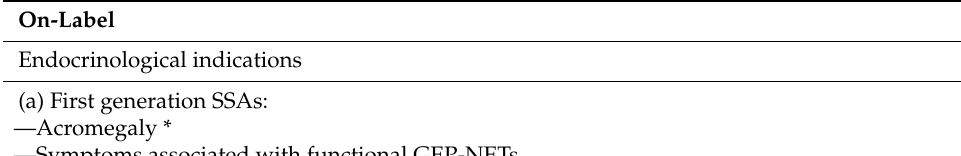
Table 1. Indications of medical treatment with